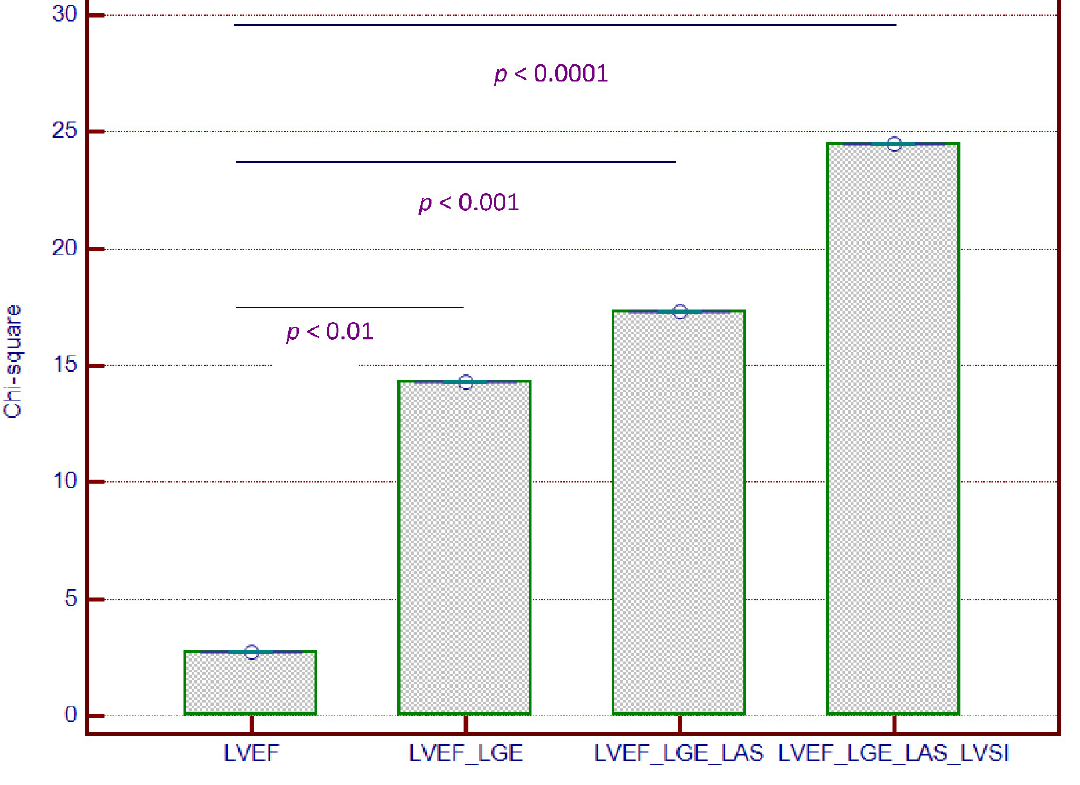
Figure 4. Incremental predictive value of LVSI and LAS added to LVEF and to LGE for outcome in patients with NIDCM. Abbreviations: LAS, left ventricular long axis strain; LGE, left ventricular late gadolinium enhancement; LVSI, left ventricular sphericity index; NIDCM, nonischemic dilated cardiomyopathy.